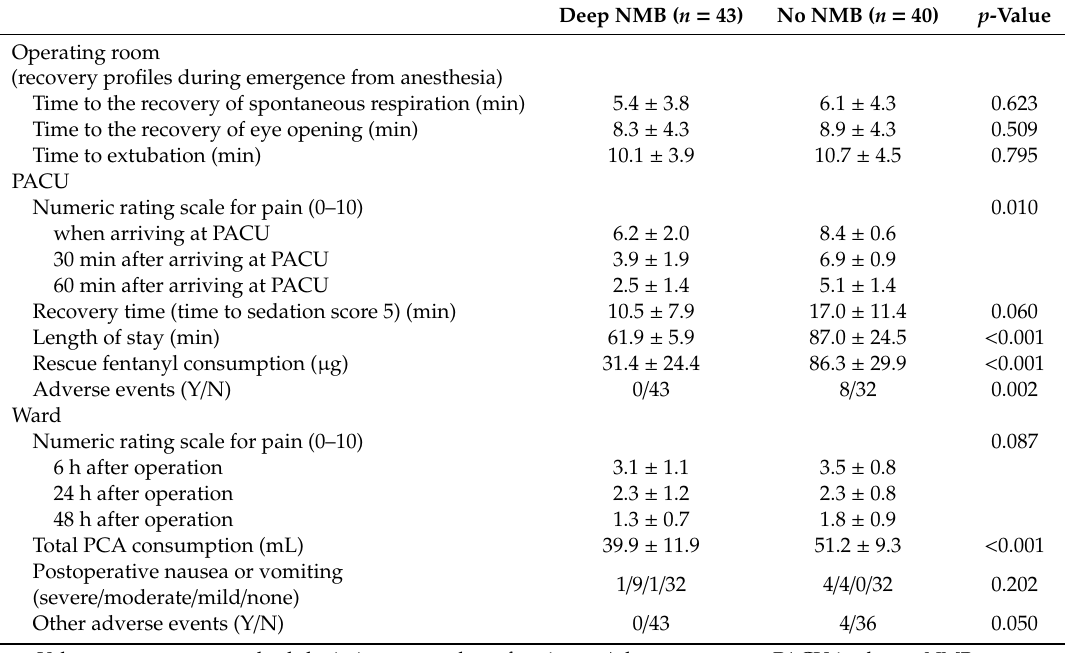
Table 3. Postoperative outcomes in the operating room, post-anesthesia care unit (PACU) and